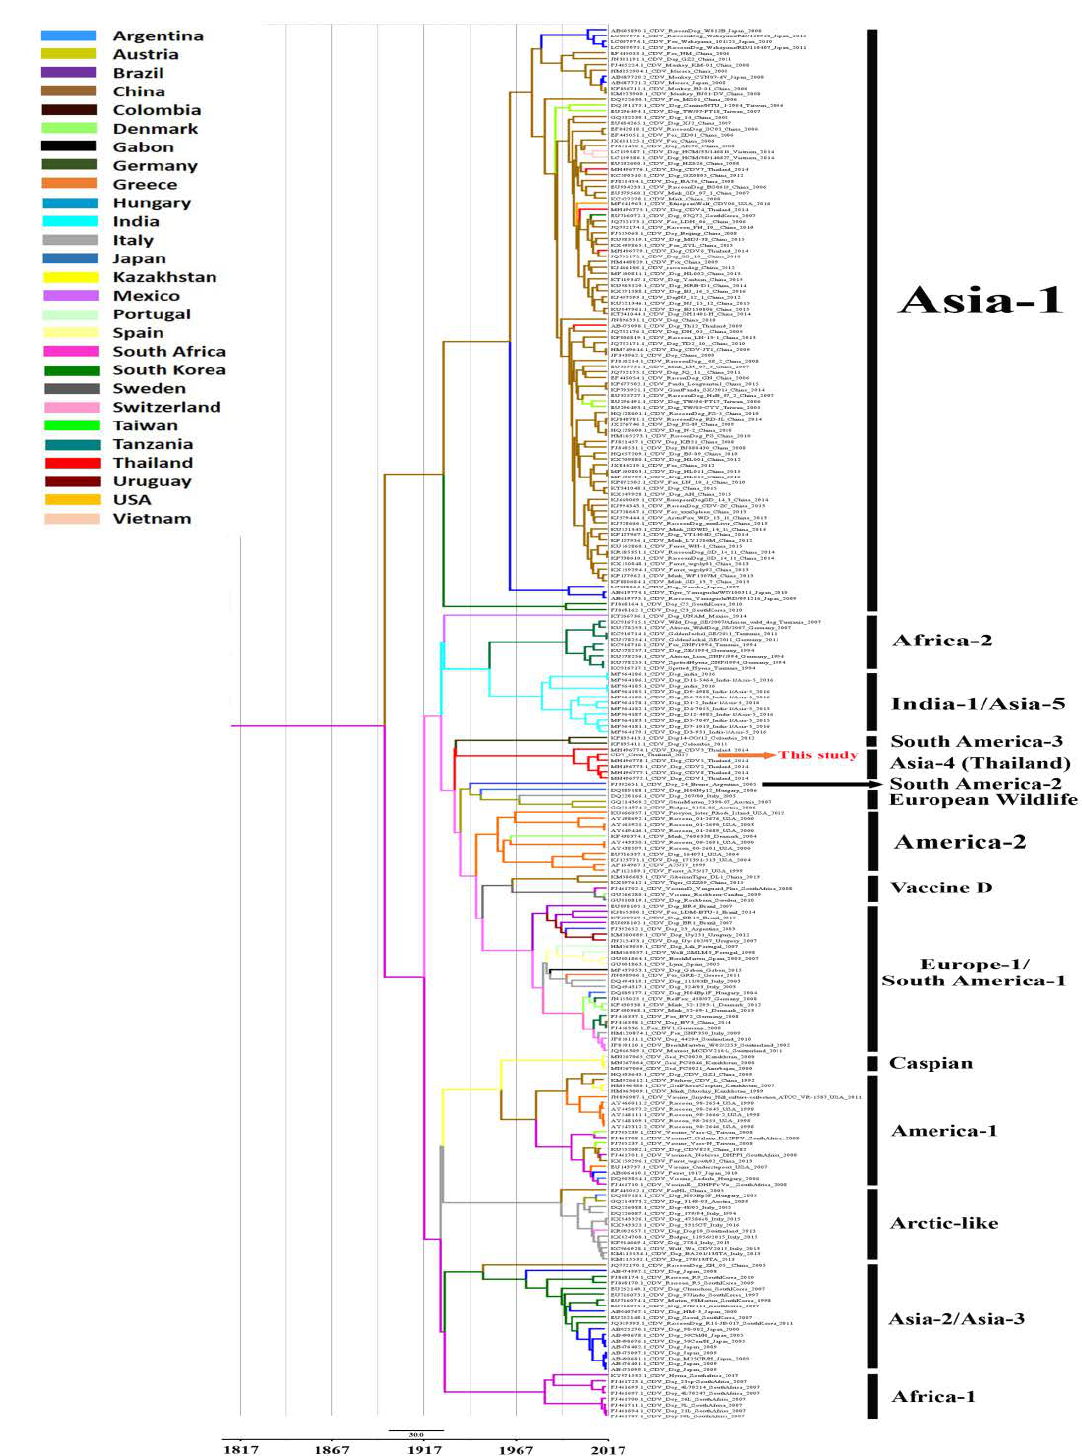
Figure 3. Maximum clade credibility (MCC) tree of 241 full-length H genes of CDVs available in the GenBank database for the 1975–2017 period. The MRCAs of these strains are indicated with their dates of existence. The phylogenetic branches are colored according to geographical locations in which the strains were detected.